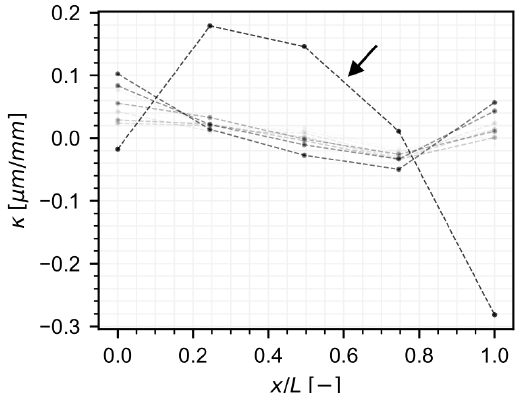
Figure 13. Curvature over time (lighter tones correspond to earlier times). Arrow highlights curvature after prestressing and form removal.